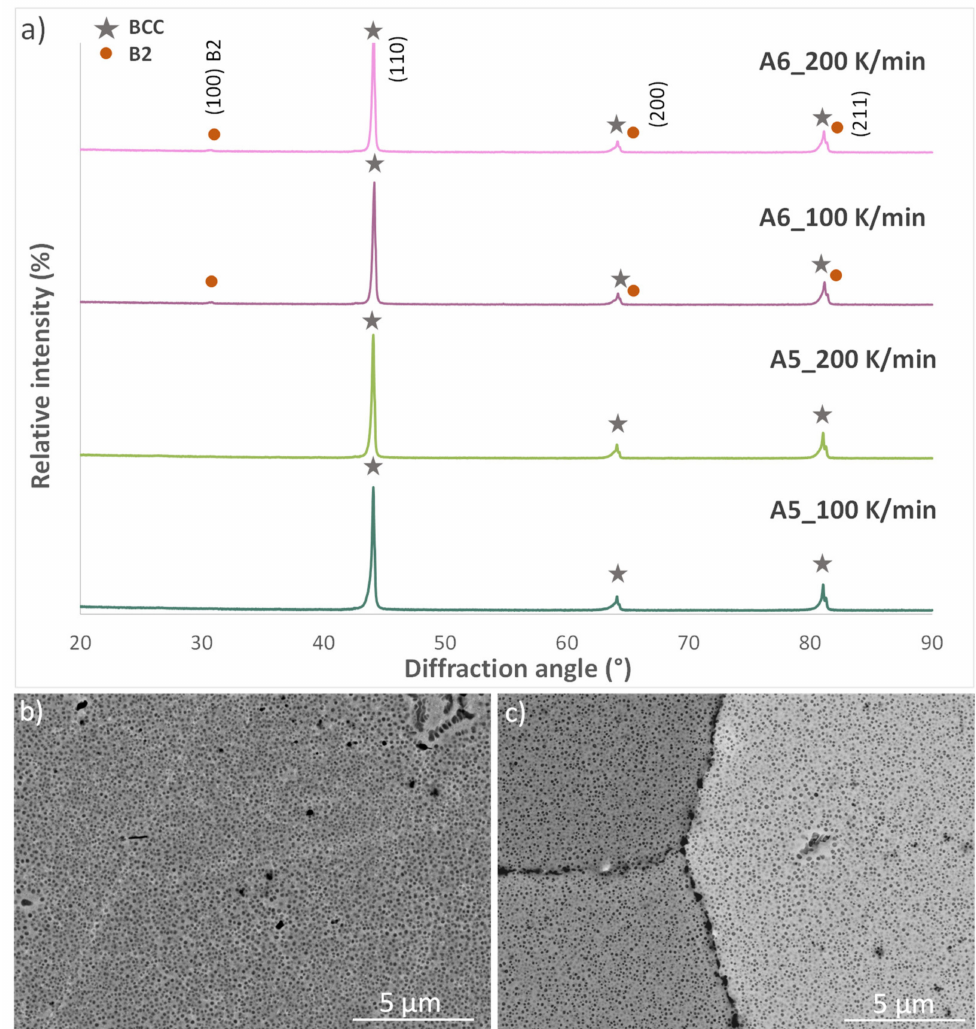
Figure 4. ( a ) XRD spectra of A5 and A6 sintered at heating rates of 100 and 200 K/min. SEM detail of the microstructure of the alloy A6 sintered at ( b ) 100 K/min and ( c ) 200